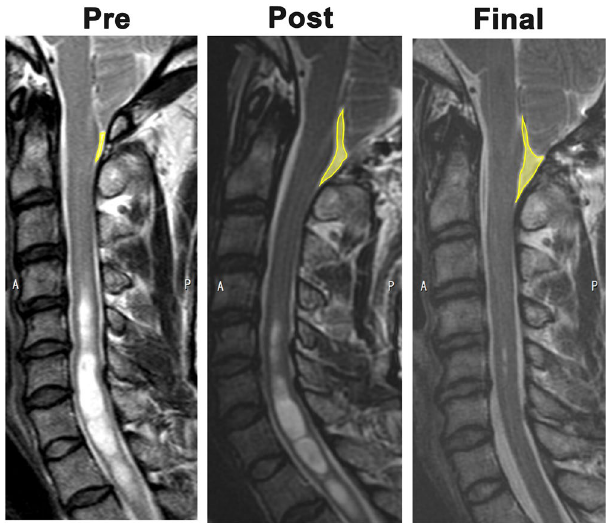
Figure 1. pSAS was defined as the area between the dura mater and spinal cord from the foramen magnum to C2 on a midline sagittal image on T2-weighted imaging. The yellow line represents the outline of the pSAS. Representative MRI image with syrinx improvement. Right, preoperative images; Middle, postoperative images; Left, images at final